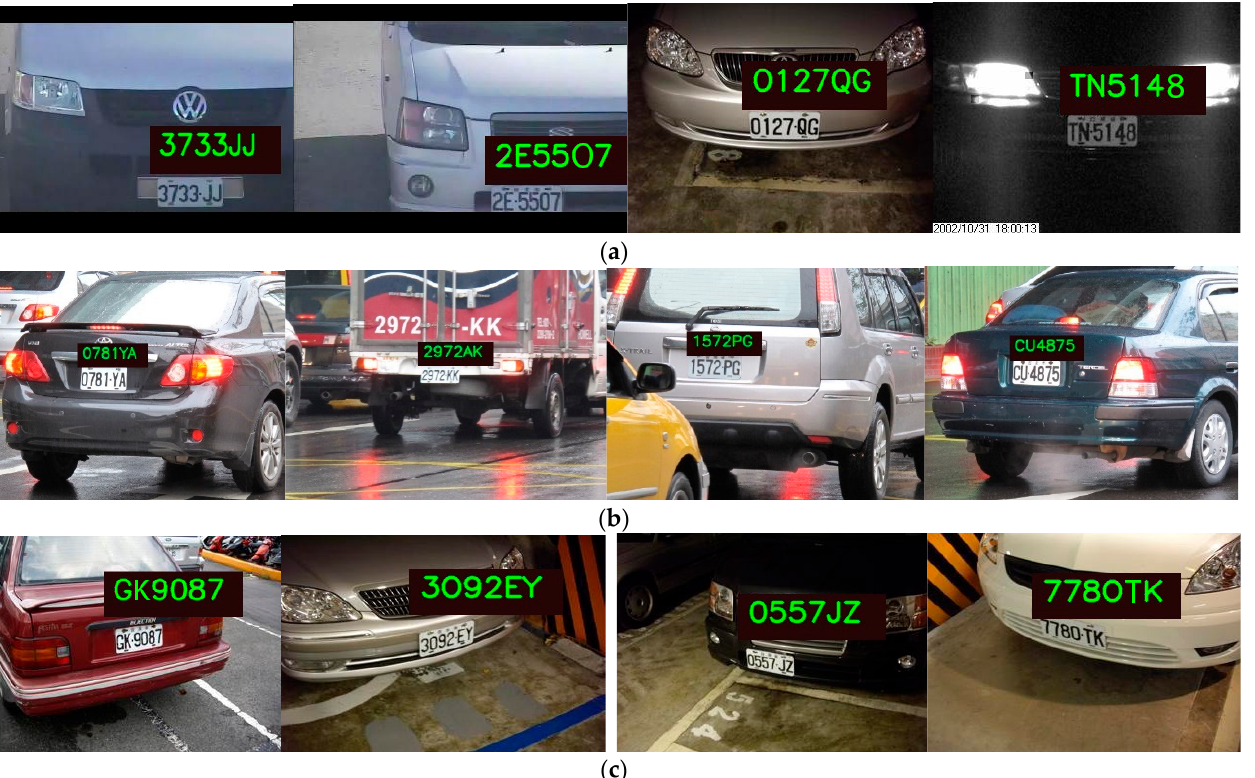
Figure 6 . The LPR on the AOLP dataset is organized under ( a ) Access control, ( b ) Tra ffi c law en- forcement, and ( c ). Road patrol